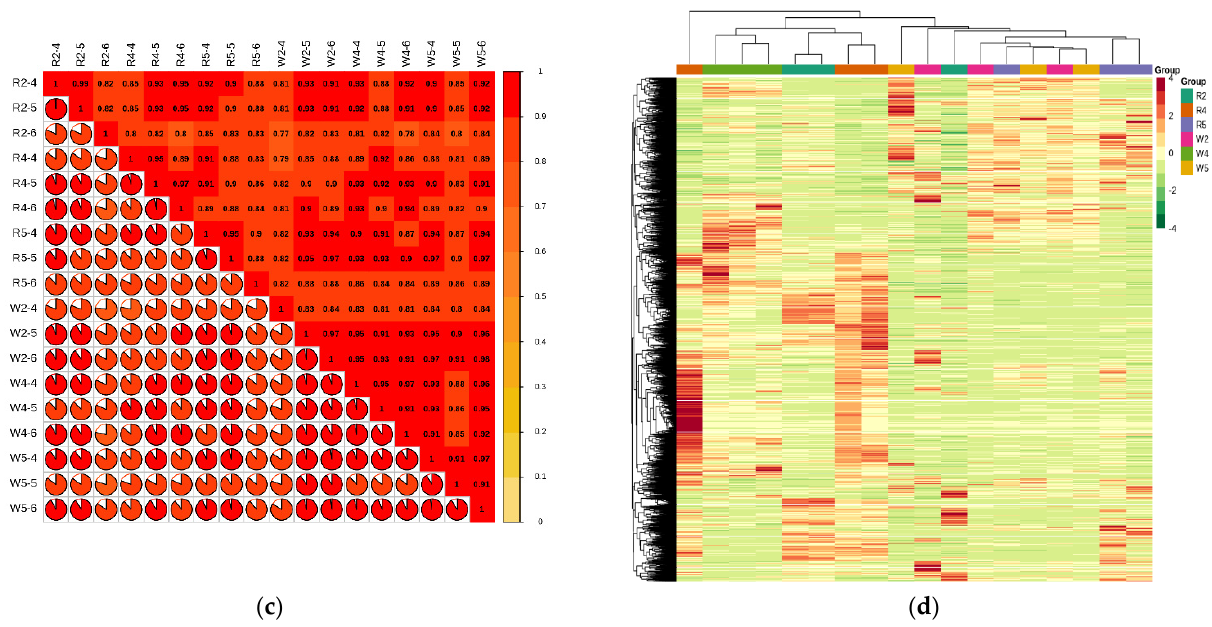
Figure 5. ( a ) Gene expression box line plot. Abscissa indicates different samples. Ordinate indicates logarithmic values of sample expression FPKM. The graph measures the distribution of overall gene expression levels for each sample. ( b ) Expression density distribution plot. Different colors of curves in the graph represent different samples. Abscissa of points on the curve indicates logarithmic values of FPKM for corresponding samples. Ordinate of points on the curve indicates probability density. ( c ) Correlation heat map. Pearson’s correlation coefficient (R 2 ) > 0.8 between biological replicate samples. ( d ) Cluster heat map. Abscissa indicates sample names and hierarchical clustering results. Ordinate indicates DEGs and hierarchical clustering results. Red and green indicate high and low expression, respectively.